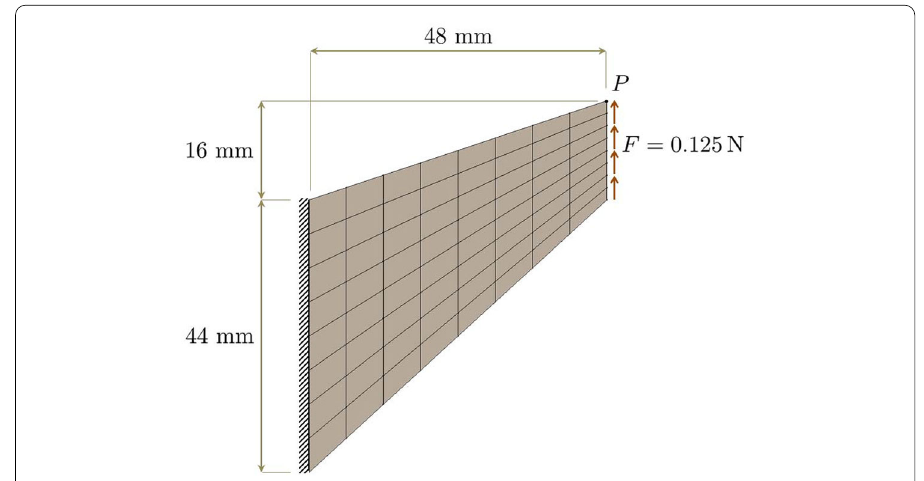
Fig. 3 Cook’s membrane, geometry, boundary conditions, loading and discretization